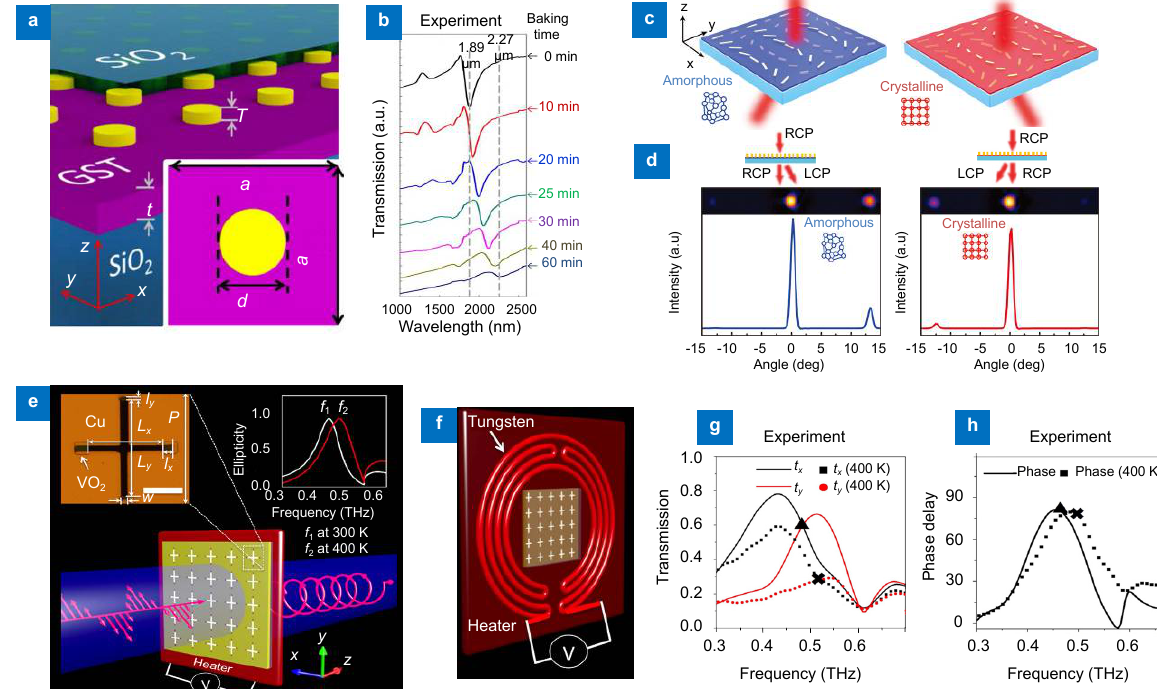
Fig. 10 | Tunable metamaterials using GST as the active material . ( a ) Schematic diagram of the plasmonic metamaterial which has an array of gold nano-disks on a thin layer of GST ( T= 40 nm, t= 20 nm, d= 280 nm, a= 1.2 µm). ( b ) Measured normalized transmission spectra of continuously tuning of the hybrid plasmonic metamaterial measured at different baking time during the crystallization process. ( c ) The schematic view of the active plasmonic metasurface for beam switching which consists of a 50 nm thick GST-326 layer underneath a geometric phase metasurface for beam switching (two types of nano-antennas A and B with different plasmon resonances are alternated line-wise), when the active layer is in the amorphous phase, only type A rods interact with the incident light and deviate the beam to the left and when the active layer is in the crystalline phase, only type B rods interact with the incident light and deviate the beam into the opposite direction due to their relative orientation (right). ( d ) Infrared camera images and intensity plots of the beam transmitted by the active metasurface in the amorphous (left) and crystalline (right) state. ( e ) Schematic view of switchable THz quarter-wave plate design. The top left inset is a microscope image of one unit cell in the fabricated sample ( P= 150, L x = 90, L y = 124, l x = 9, l y = 5 and w= 9 μ m, and the scale bar is 50 μ m). The top right inset is the simulated ellipticities of the output THz waves. ( f ) Schematic backside view of the resistive heater with a square aperture (6 mm× 6 mm) milled at the center to allow THz to pass through. ( g ) Measured transmission spectra along two slots at 300 K (solid line) and 400 K (dot line). ( h ) Measured the phase difference between y - and x -axes at 300 K (solid line) and 400 K (dot line). Figure reproduced from: ( a , b ) ref. 92 , Optical Society of America; ( c , d ) ref. 167 , Creative Commons Attribution 4.0 International License; ( e – h ) ref. 96 , Creative Commons Attribution 4.0 International